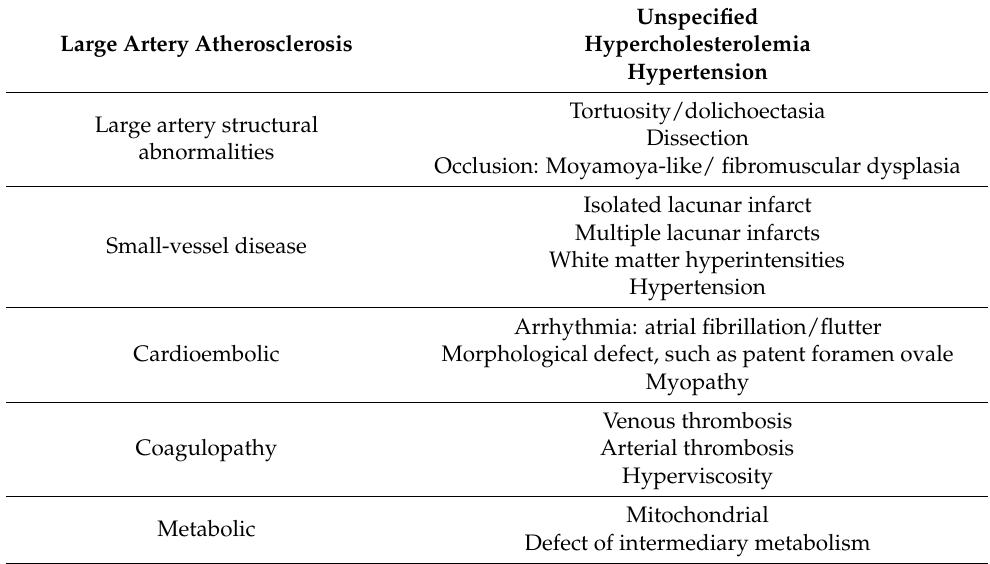
Table 1. Ischemic stroke subtypes classification by genetic risk, modified from Ilinca et al.